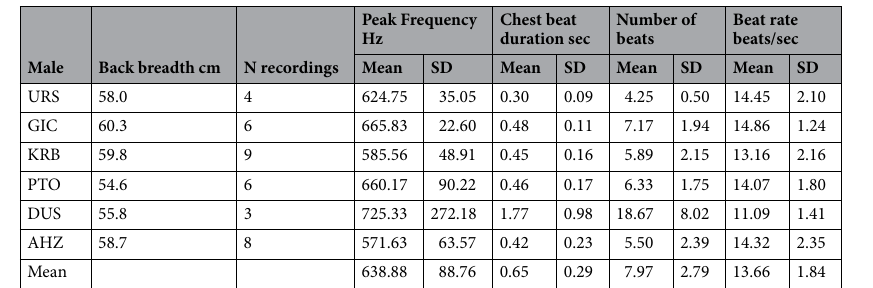
Table 2. Acoustic recordings and the variables examined. Acoustic recordings were made opportunistically at different observation times from the behavioural observations.